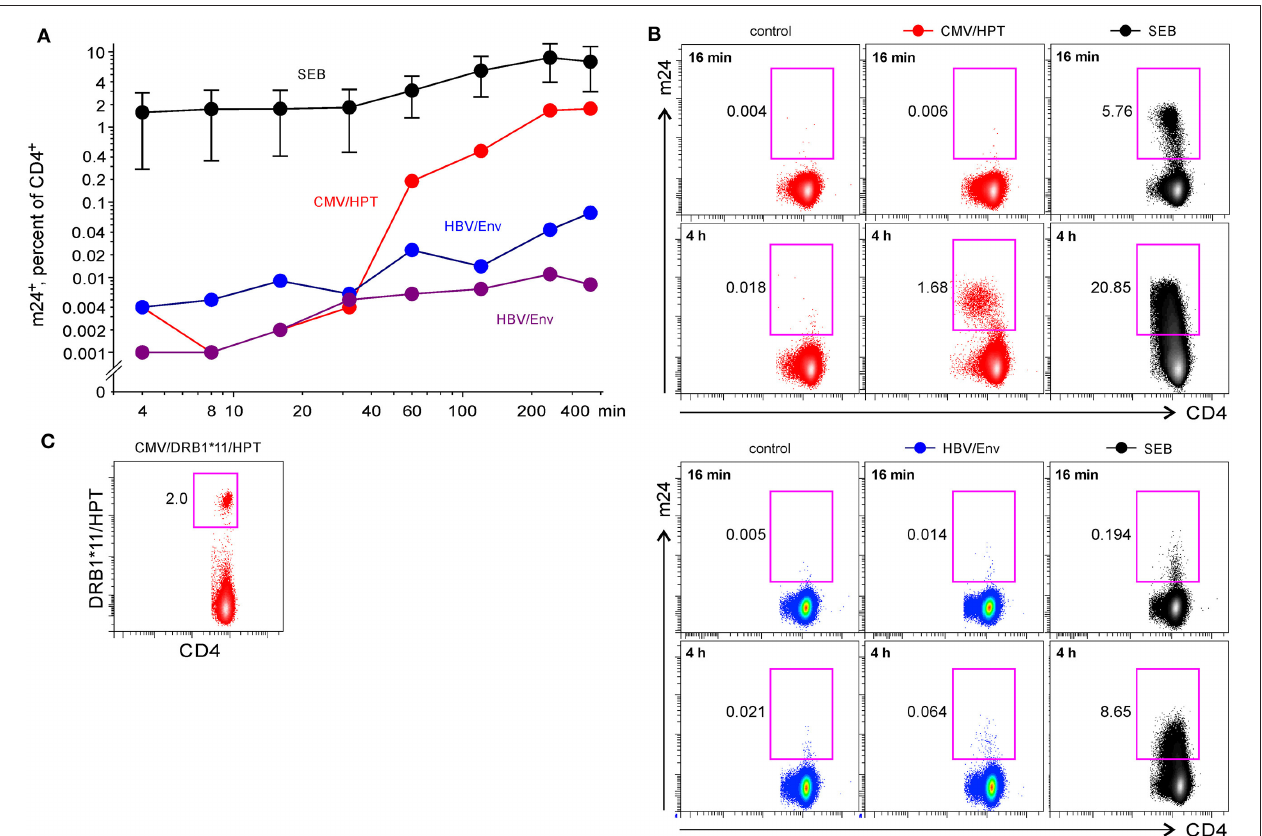
FIGURE 3 | The flow cytometry assessment of antigen-specific CD4 + WB T cells by staining of activated β 2 -integrins with m24 Ab. The cells were stained with m24 Ab, treated with EDTA afterward, and then stained with CD3, CD4, and CD8 Abs, gating strategy is displayed in Figure 1A . (A) The time course of m24 Ab staining following incubation of WB cells with SEB (black, four donors, presented as mean ± SEM), CMV/HPT peptide (red, one donor), or HBV/Env pool of overlapping peptides (blue and purple, two donors) for 4, 8, 16, 32, 60, 120, 240, or 360min. Background from the relevant unstimulated sample was subtracted. (B) Examples of m24 Ab staining obtained after 16 or 240min, i.e., 4h without stimulation (control) or in the presence of matched peptides or SEB of the donor with a CMV/HPT CD4 + reactivity (top panel). One of the two HBV vaccinees (bottom panel). (C) DRB1*11/HPT multimer staining was performed without CMV/HPT peptide stimulation and was obtained from the same donor as in (B) (top panel). Numbers indicate frequencies among CD4 + T cells in